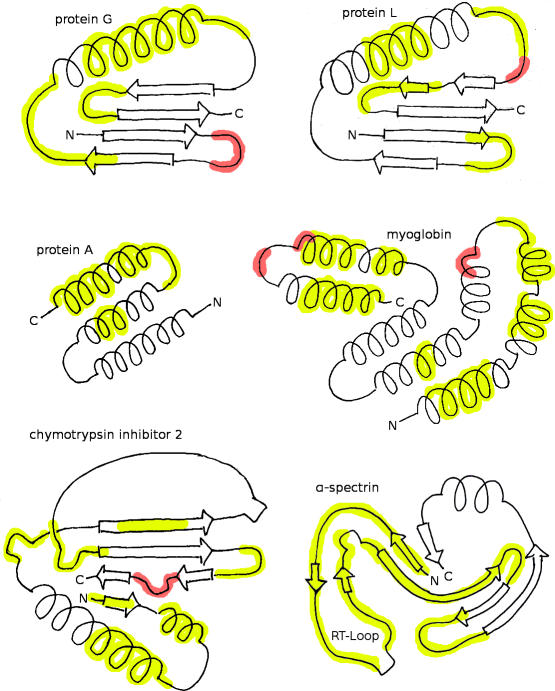
Distribution of Kinks in the Topology of Protein Structuresα helices and 310 helices are drawn as coils, hydrogen-bonded β-turns are drawn as a notch, and β strands are drawn as arrows.Yellow indicates helical-turn [-aaa-] and red indicates reverse-turns [baab]. 11 of the 14 α helices contain a helical-turn. The turns of all seven β hairpins contain a peptide fragment that is structured.